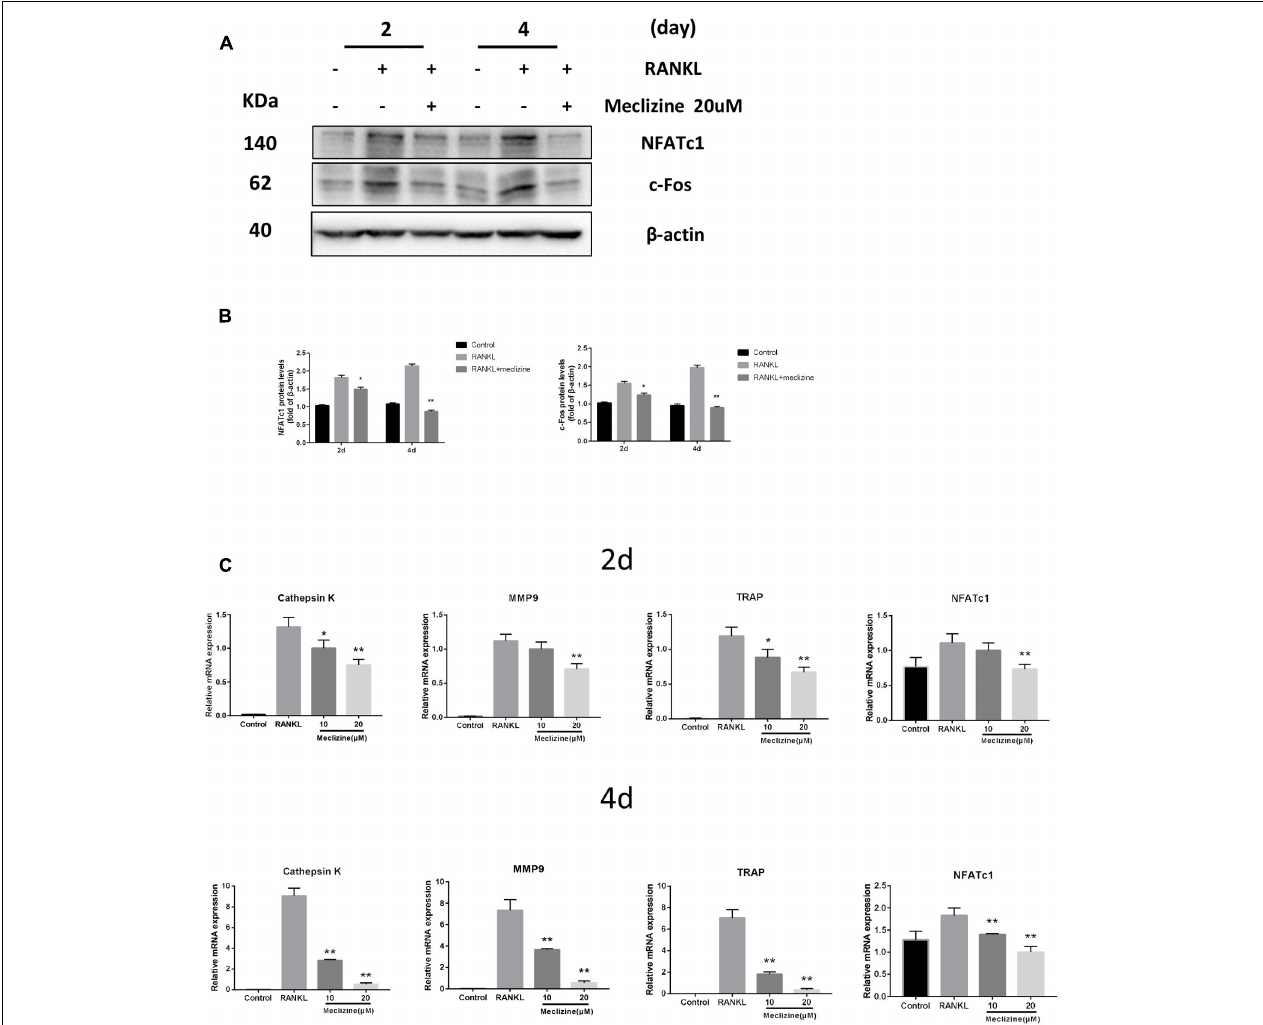
FIGURE 6 | Meclizine decreases expression of osteoclast maker genes in BMMs. (A,B) Meclizine inhibits RANKL-induced protein expression of NFATc1 and c-Fos. BMMs were treated with or without meclizine (20 µ M) in the presence of RANKL (100 ng/mL) and M-CSF (30 ng/ml). Protein expression levels were measured by western blotting at the indicated times and β -actin was used as a loading control. The experiments were repeated three times independently; ∗ P < 0.05, ∗∗ P < 0.01 versus RANKL group. (C) Meclizine represses RANKL-induced mRNA expression of MMP9 , Cathepsin K , TRAP and NFATc1 . BMMs were treated with or without meclizine (20 µ M) in the presence of RANKL (100 ng/mL) and M-CSF (30 ng/ml) for 2 or 4 days. Total RNA was extracted and mRNA expression was determined by quantitative real-time RT-PCR. Data are represented as mean ± SD. ∗ P < 0.05; ∗∗ P < 0.01 versus RANKL